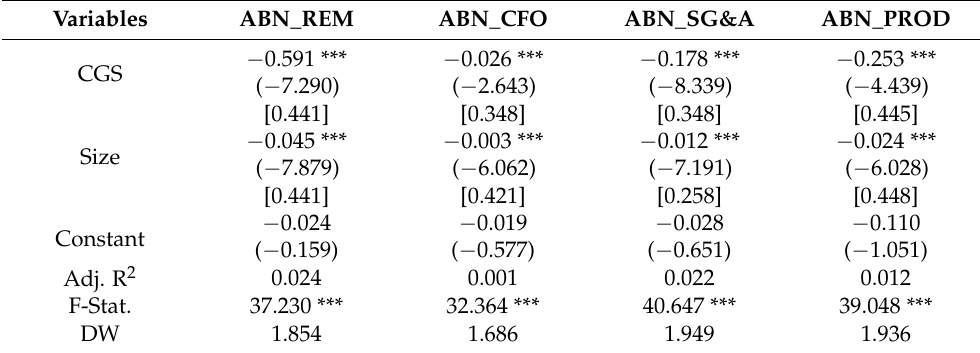
Table 7. Relationship between REM, CG, and